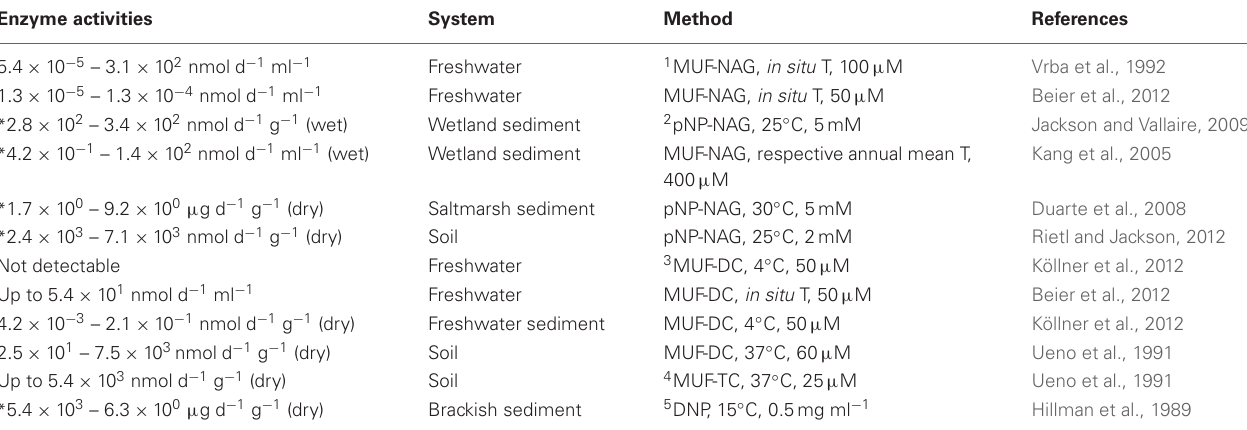
If possible, values given in different units in the original publications were transformed into a single unit (listed values do not provide a complete overview on all measurements performed but display examples, values from experimental manipulations measured along with controls from natural habitats were excluded from the table). 1 MUF-NAG: β -N-acetyl-hexosaminidase/chitinase hydrolysis rates estimated based on the fluorogenic substrate analog N-acetyl-b-D-glucosaminide